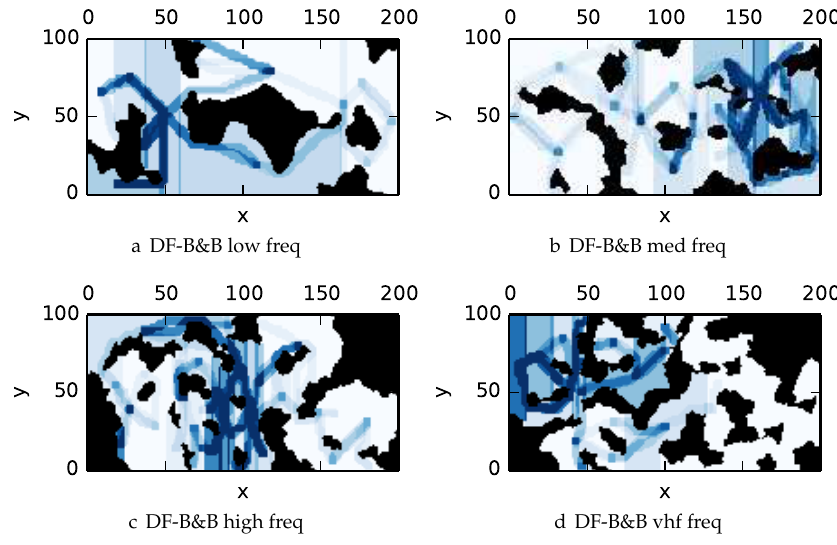
Figure 14. Multipass coverage plans in environments with uniform information for the DF-B&B coverage planner